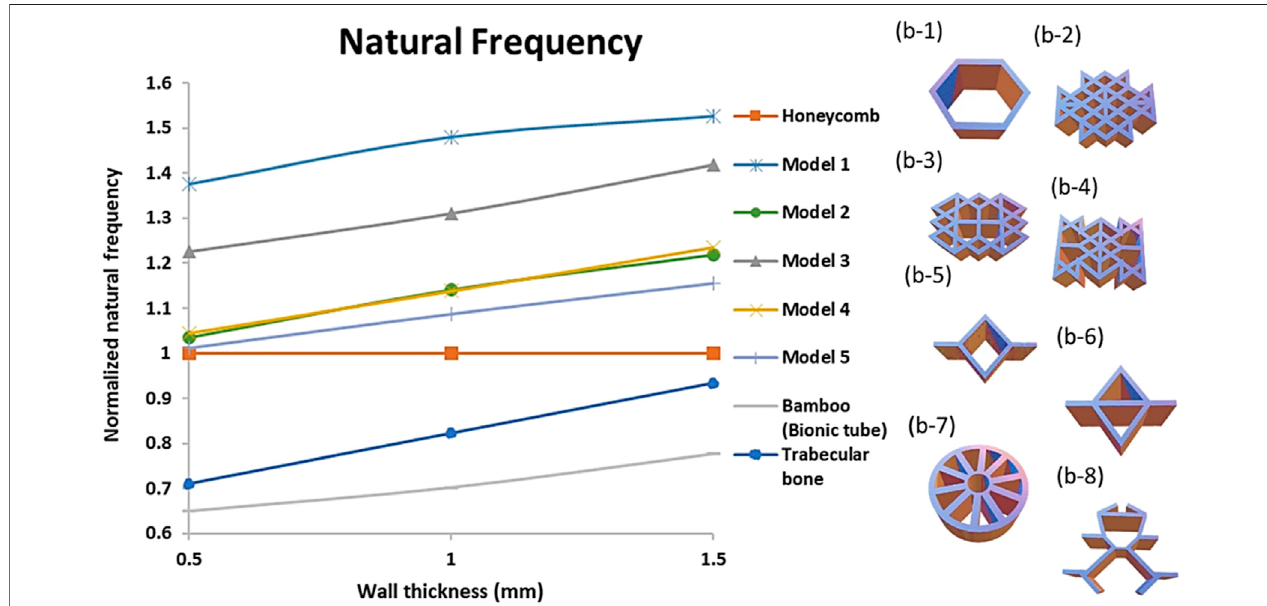
FIGURE 7 | Numerical simulations for Wall thickness versus Normalized natural frequency of optimal cellular unit cells compared with biomimetic cellular unit cells, (b-1) Honeycomb, (b-2) Model 1, (b-3) Model 2, (b-4) Model 3, (b-5) Model 4, (b-6) Model 5, (b-7) Bamboo (Bionic tube) and (b-8). Trabecular bone.